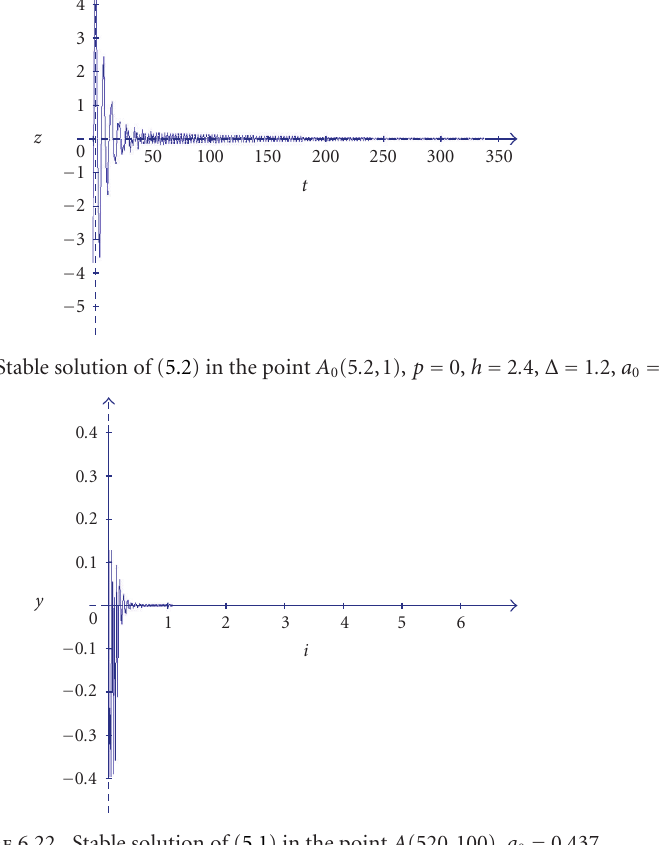
Figure 6.22 . Stable solution of (5.1) in the point A (520,100), a 0 = 0 .